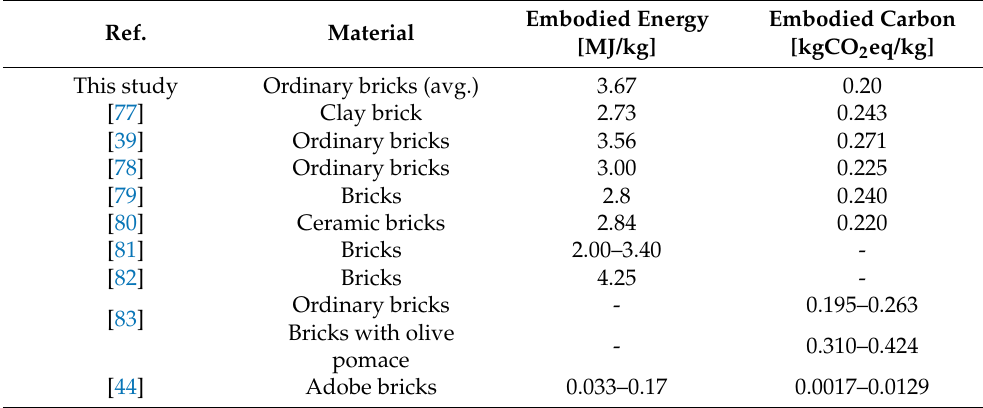
Table 9. Literature values for the embodied energy and carbon of brick and concrete products.